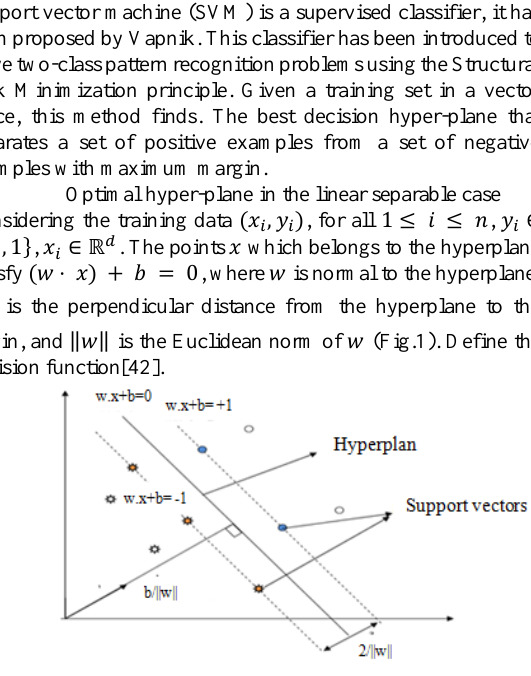
Figure 1: A Linear SVM Two-Dimensional Space 𝑓(𝑥) ∶= sign ((𝑤 ⋅ 𝑥) +